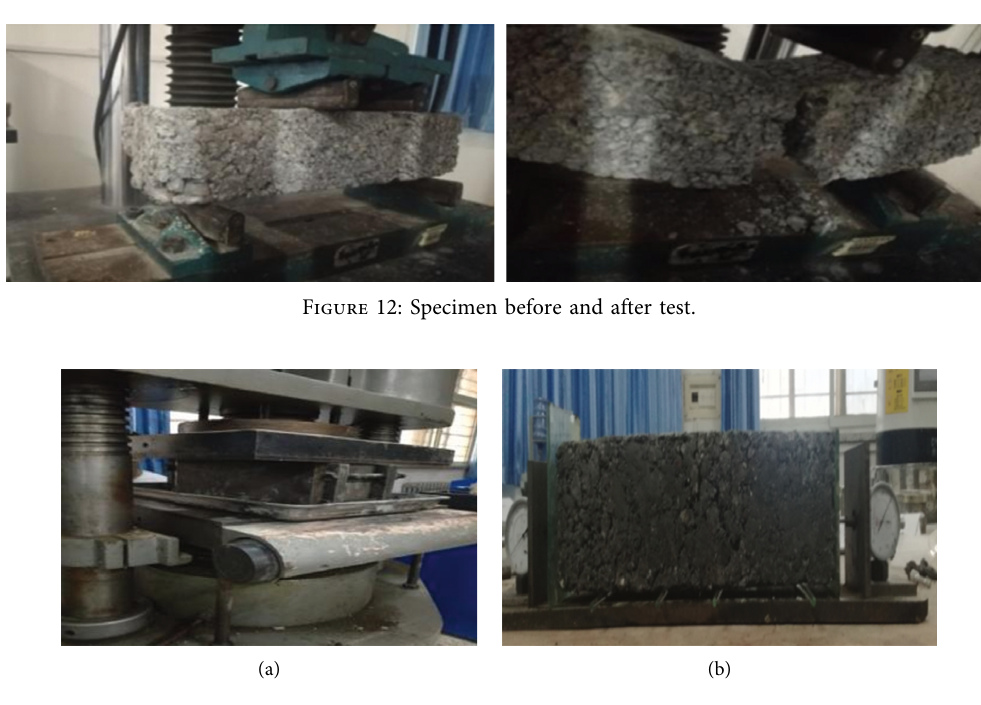
Figure 13: Dry shrinkage test. (a) Production of dry shrinkage specimen. (b) Dry shrinkage test device and specimen.